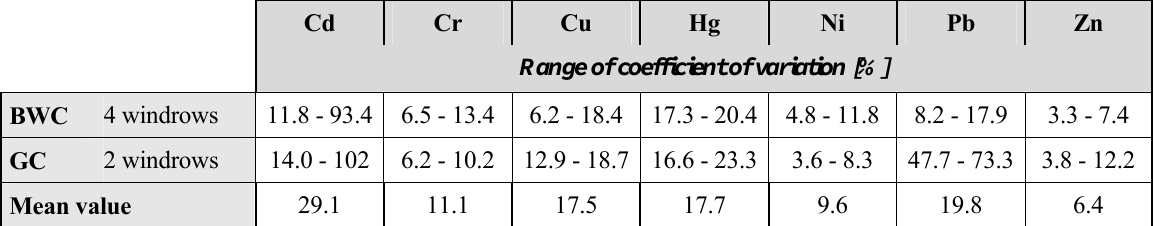
Limit values for Composts from MSW